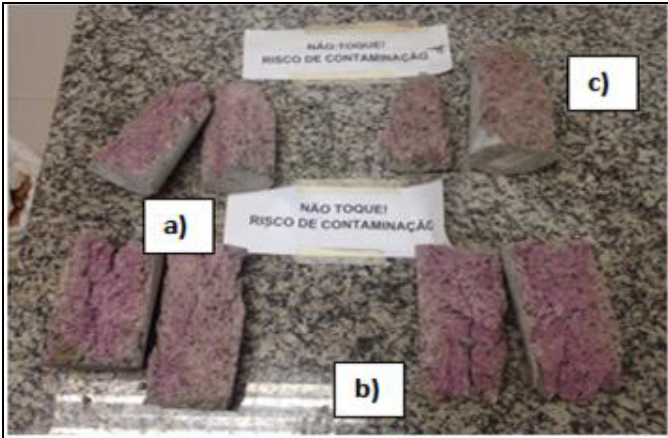
Figura 12: Observação dos CP’s aos 120 dias após aplicação do indicador químico de fenolftaleína. a)Traço com 0,0% de fibra; b)Traço com 0,5% de fibra; c)Traço com 1,0% de